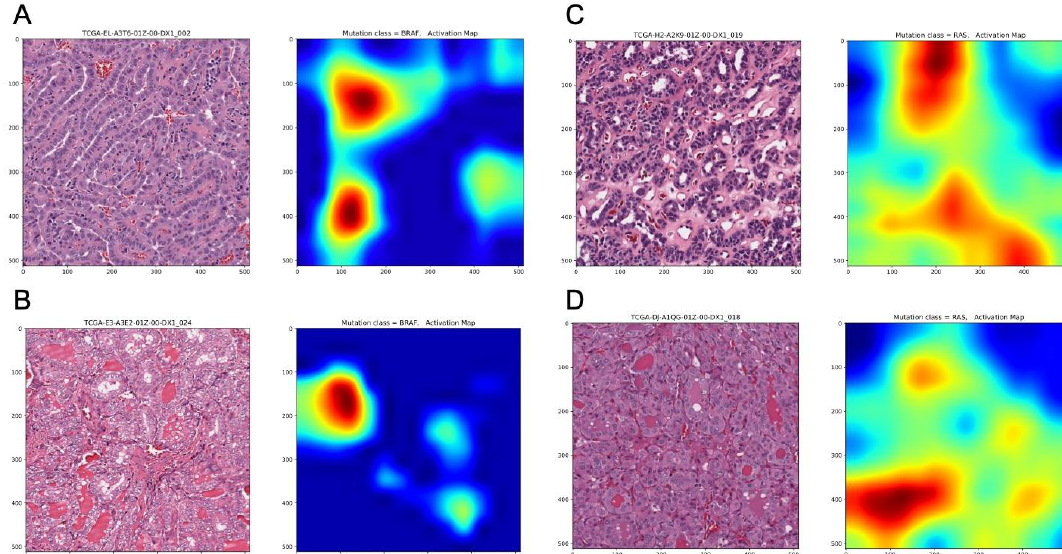
Figure 3. Representative histopathological images with corresponding activation maps of BRAF V600E and RAS mutations. ( A ) BRAF V600E mutated, Classical Histological Type, ( B ) BRAF V600E mutated, Follicular Variant Type, ( C ) RAS mutated, Classical Histological Type, ( D ) RAS mutated, Follicular Variant Type.